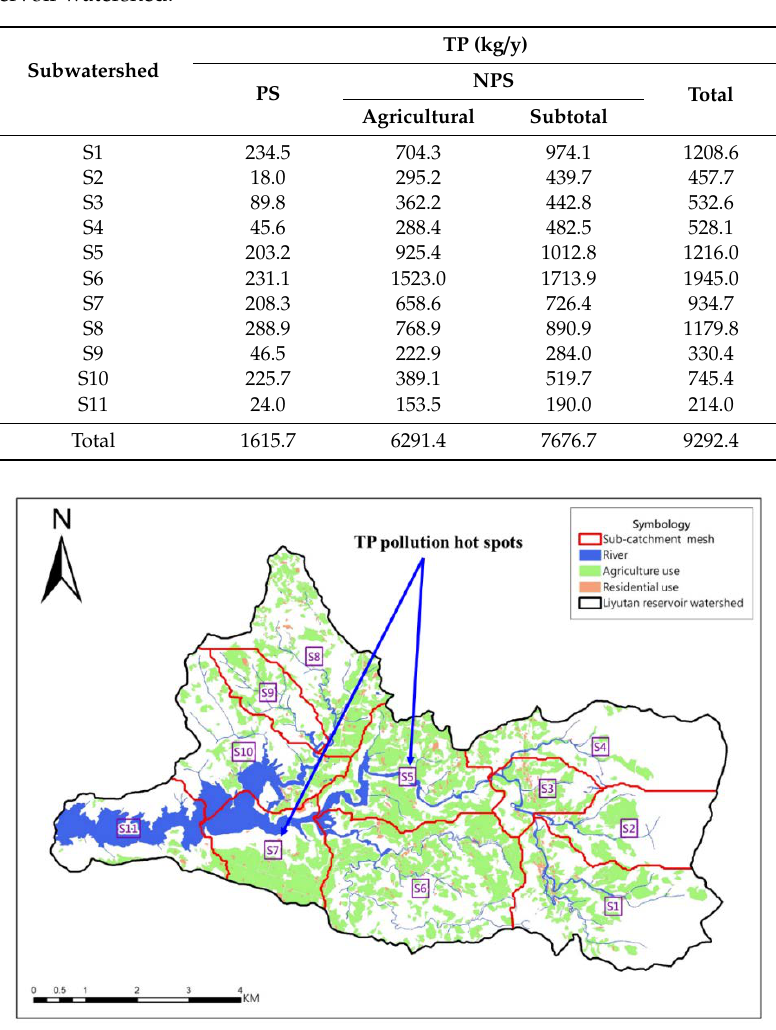
Table 3. The results of the TP loads of the point source (PS) and nonpoint source (NPS) pollution in the Liyutan reservoir watershed.